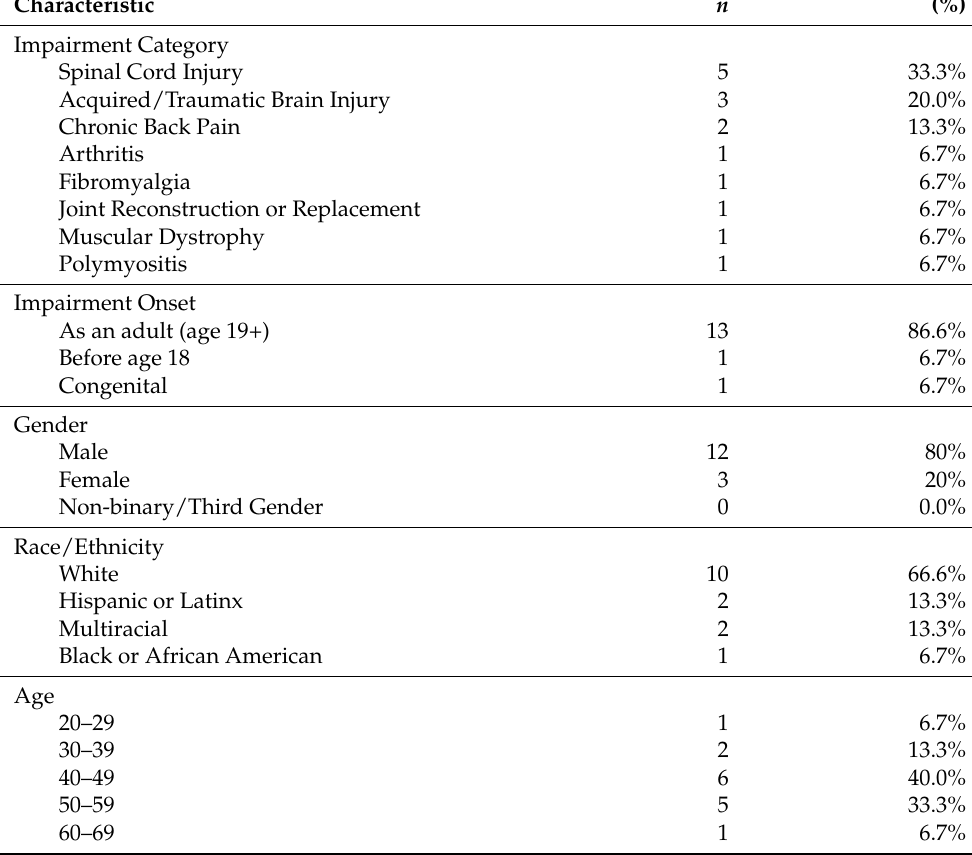
Table 6. Demographic characteristics of the qualitative sample ( n =